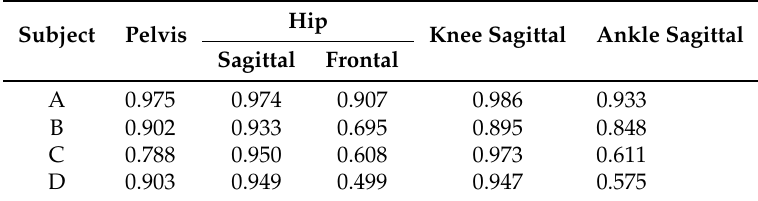
Table 3. S M index for the joint kinematics.